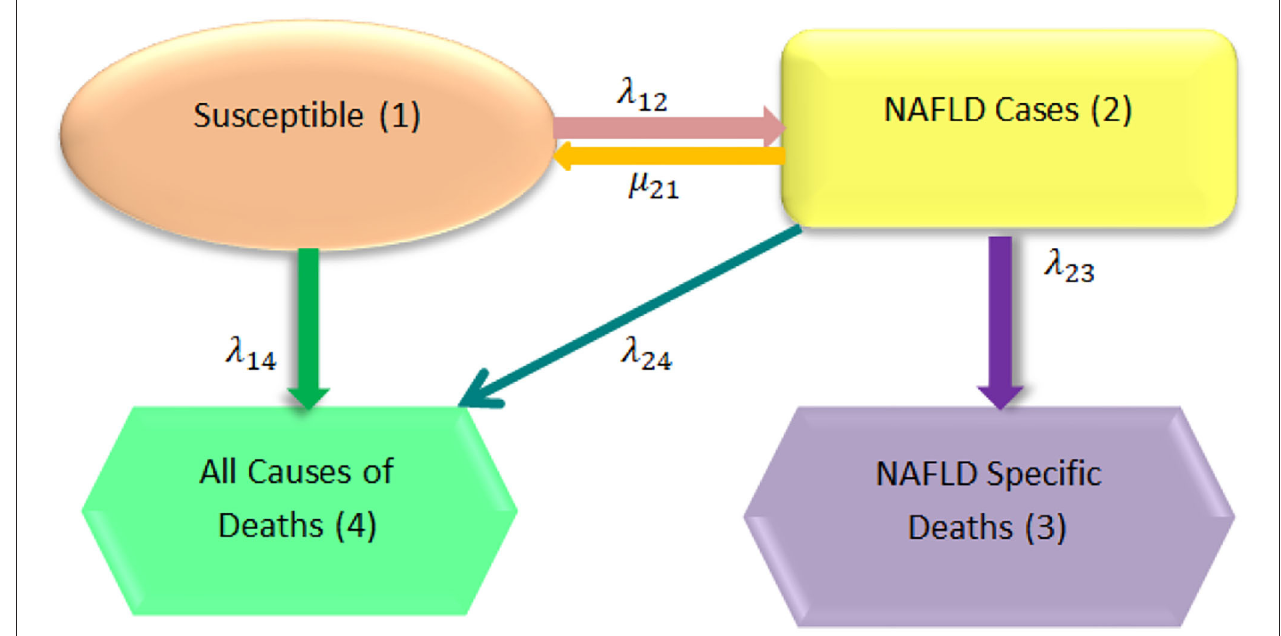
FIGURE 1 | General model structure